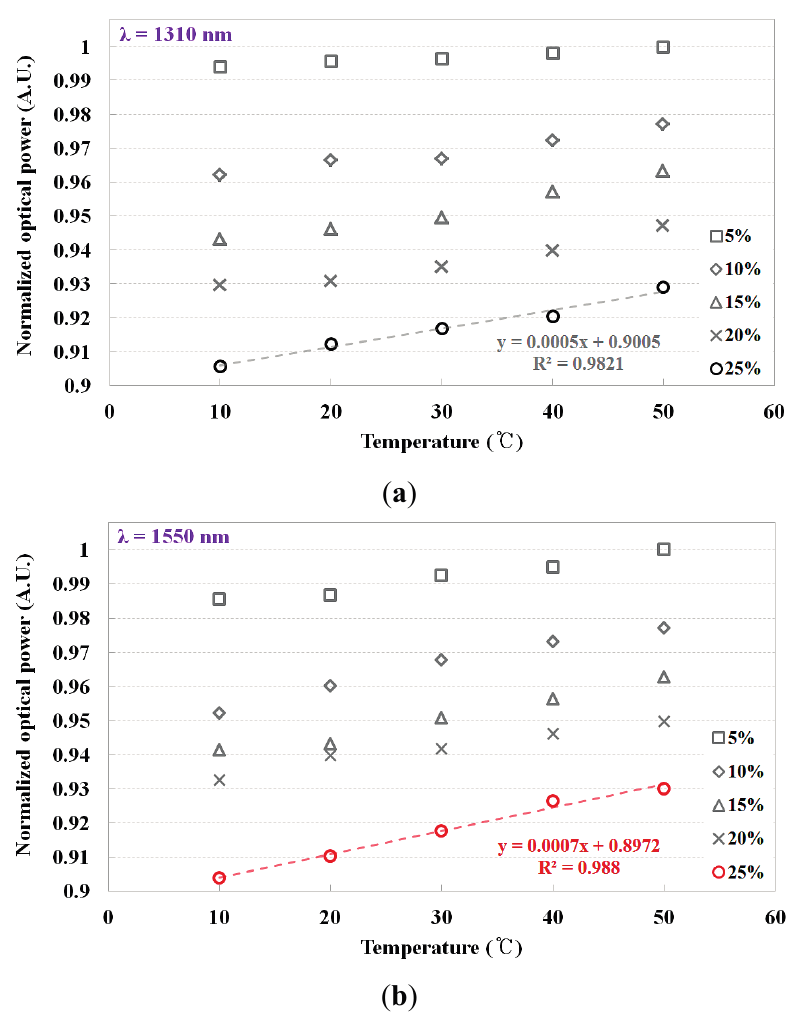
Figure 4. Comparison of the output signals of the fiber-optic temperature sensor with two wavelengths of the light source and five concentrations of the NaCl solution according to the temperature variation of the water. ( a ) λ = 1310 nm and ( b ) λ = 1550